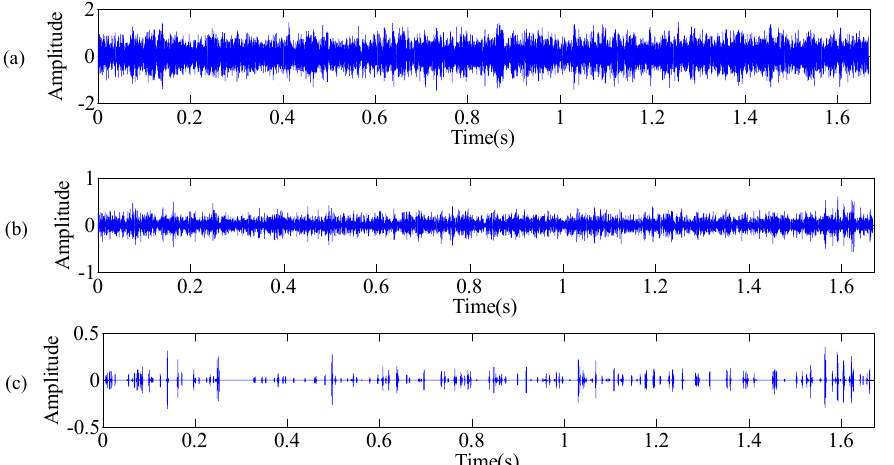
Figure 5. In 25 h: ( a ) Raw vibration signals; ( b ) reconstructed component via Dual − BP; ( c ) reconstructed component via MCA.